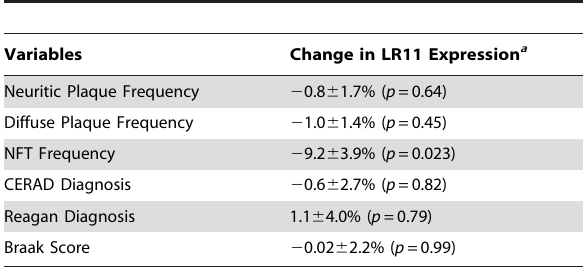
Table 6. Frontal cortex LR11 expression is not associated with AD